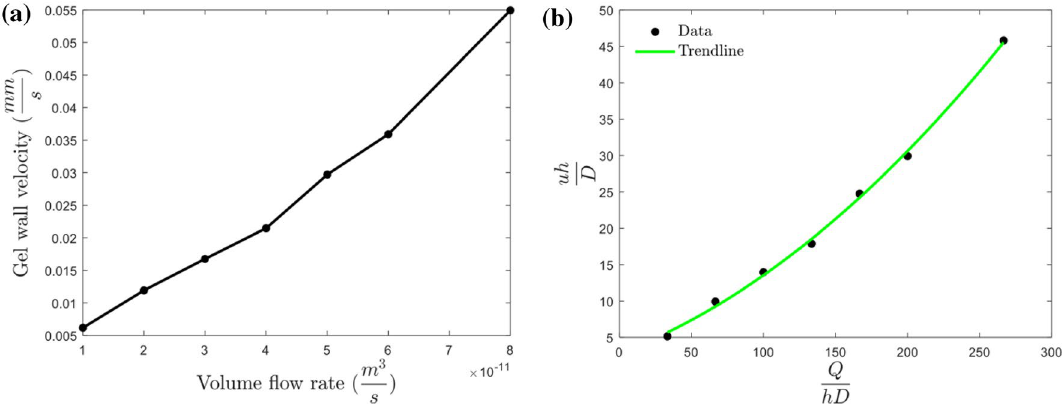
Fig. 10 a) Changes in gel wall velocity as a function of volume flow rate of Pluronic and saline solution. b) The relation between gel wall velocity, volume flow rate, channel’s height, and diffusion